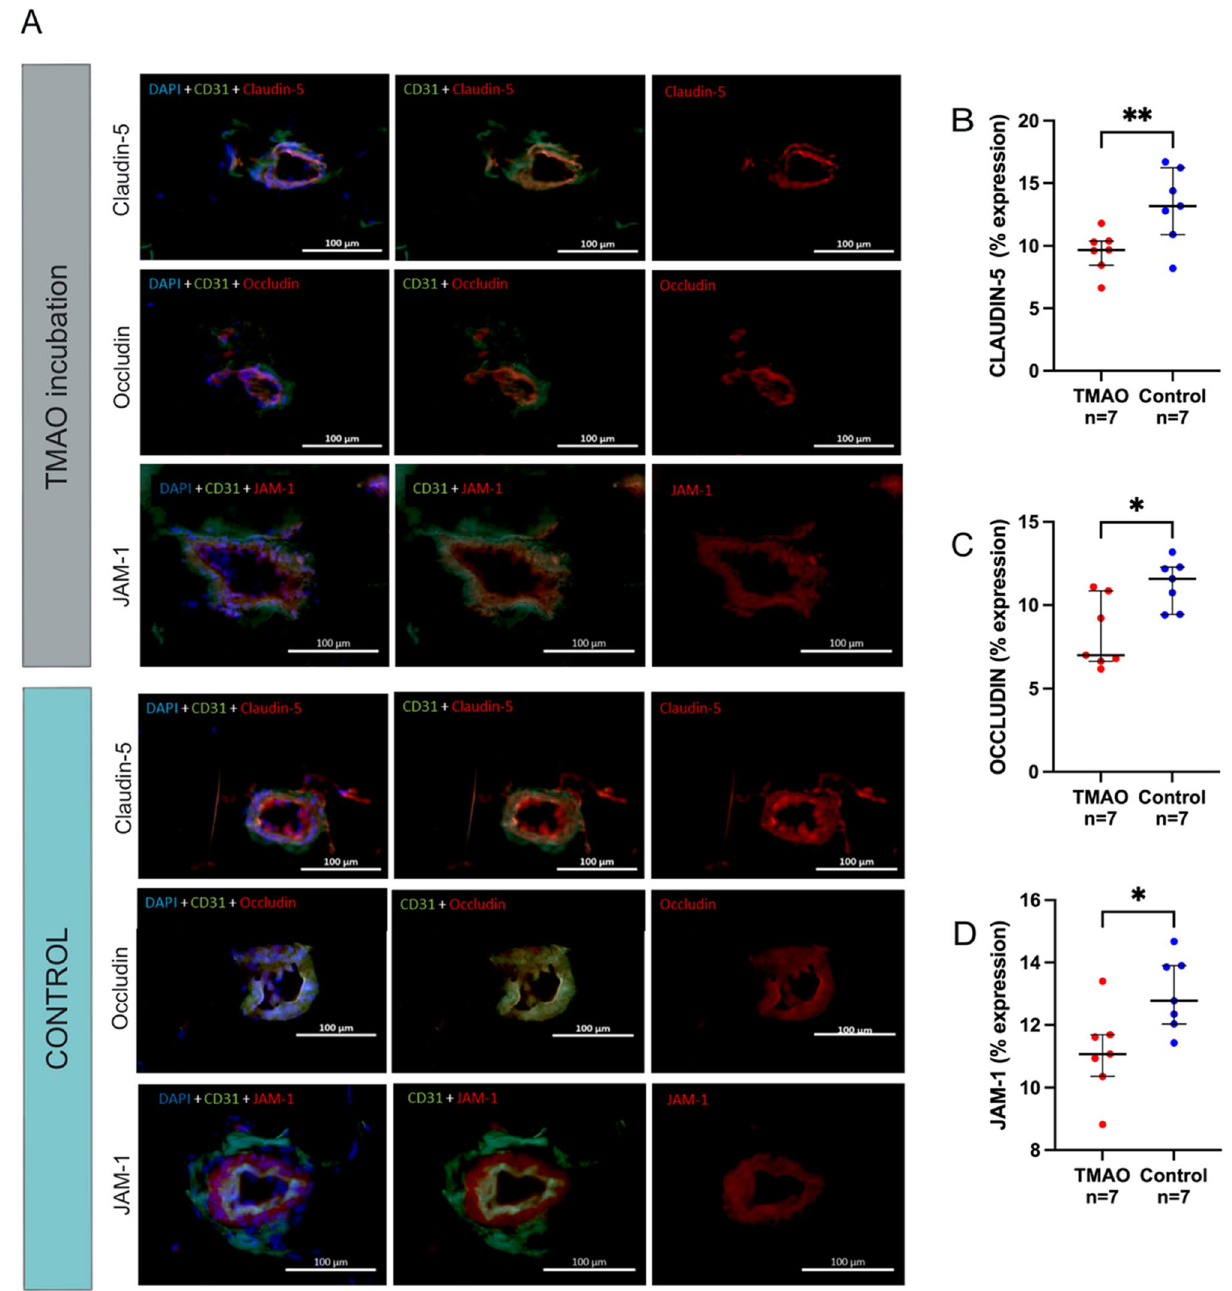
Figure 6. TMAO incubation and tight junction protein expression in subcutaneous adipose tissue. ( A ) Immunofluorescence staining of tight junction proteins (red) claudin-5, occludin, and JAM-1, nuclear staining with DAPI (blue), endothelial marker CD31 (green) in subcutaneous tissue incubated with ( A ) TMAO and ( B ) control media. Bar = 100 µm. Expression of tight junction proteins ( B ) claudin-5, ( C ) occludin and ( D ) JAM-1 in subcutaneous tissue after incubation with TMAO and control media. Results expressed in medians and interquartile range. Statistical significance * p < 0.05, ** p <